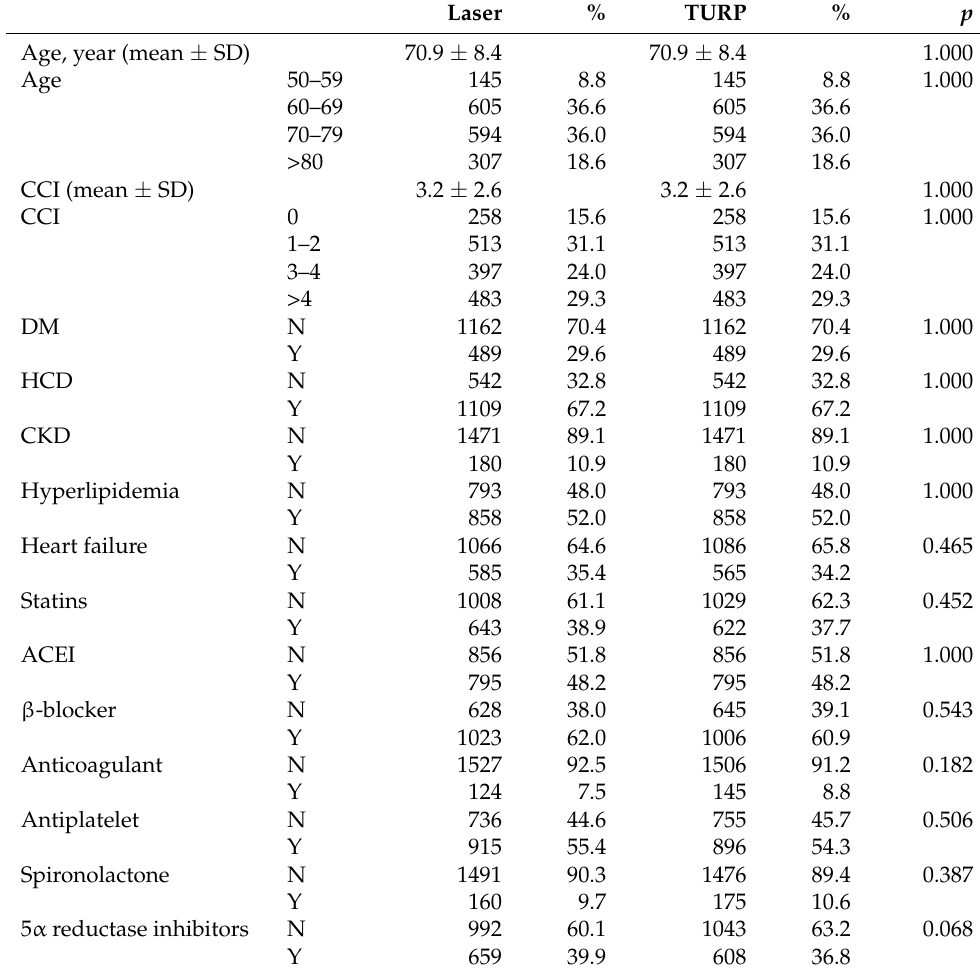
Table 1. Baseline characteristics of patients who underwent laser surgery or